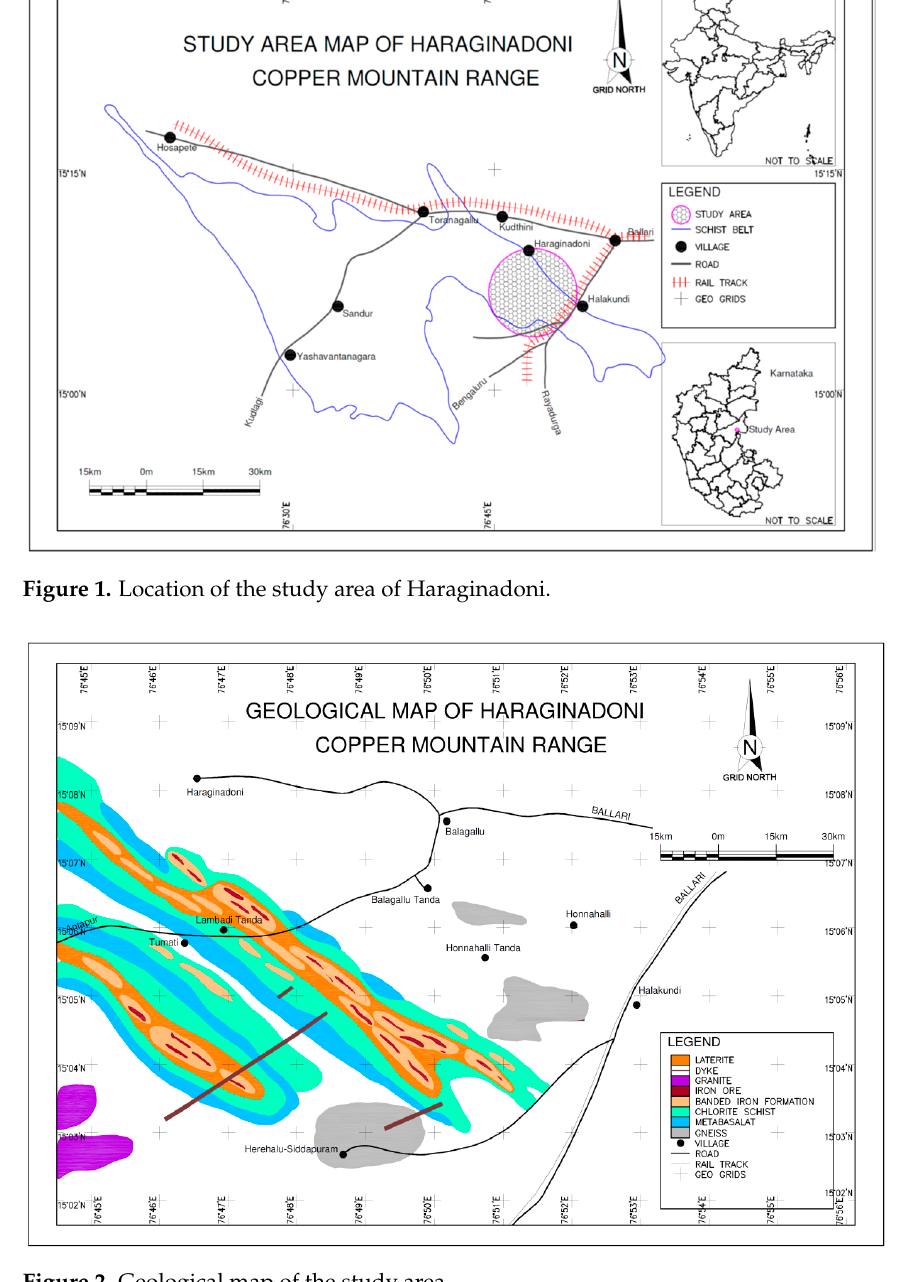
Figure 2. Geological map of the study